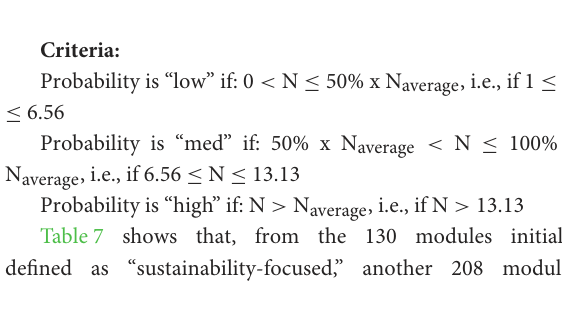
FIGURE6 Number of “sustainability-focused” and “sustainability-inclusive” modules associated to each SDG.